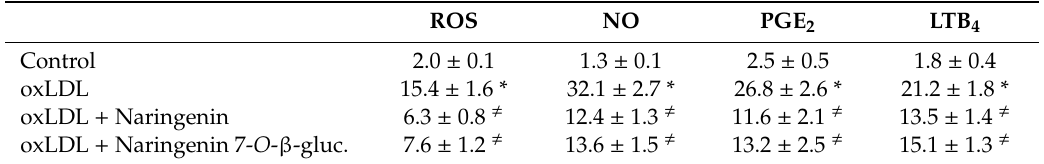
oxLDL + Naringenin 7- O - β